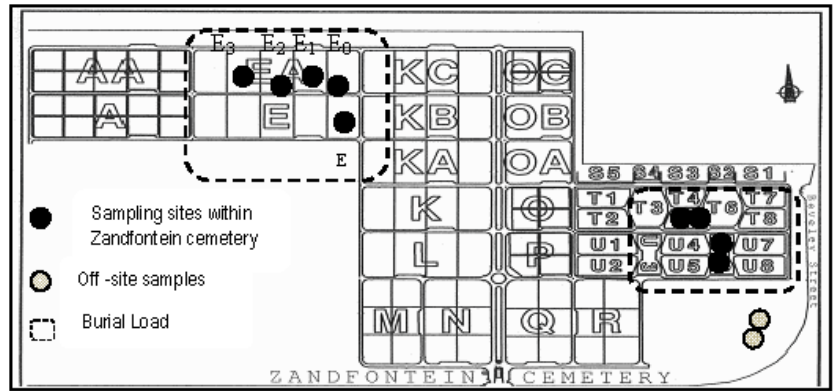
Figure 3. Location of sampling